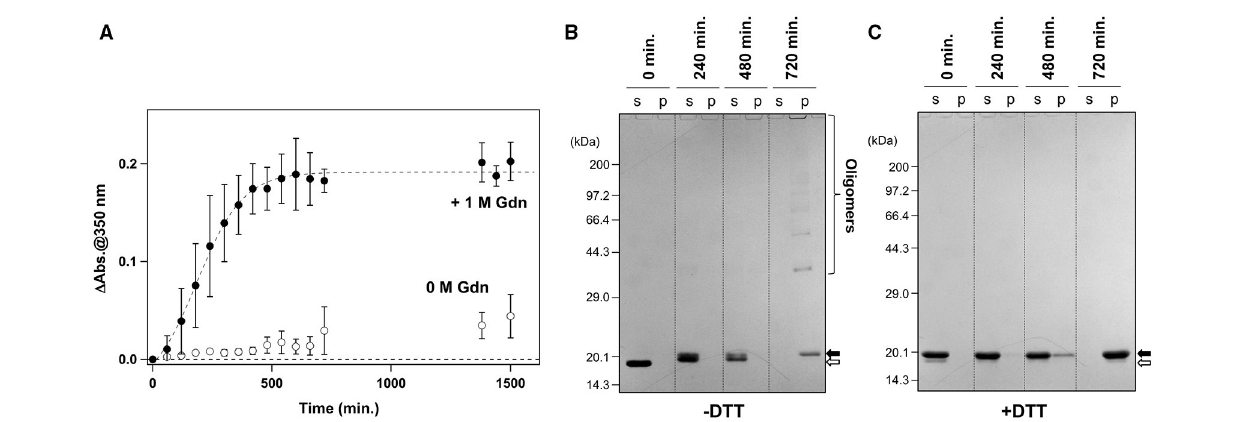
FIGURE 1 | Formation of insoluble apo-SOD1(G37R) S-S oligomers by structural destabilization. (A) Formation kinetics of insoluble aggregates from 20 µ M apo-SOD1(G37R) S - S was monitored by the increase of solution turbidity (absorbance at 350nm) in the absence (open circles) and presence (filled circles) of 1MGdn. Experiments were repeated more than three times to estimate error bars (standard deviation). (B,C) During the aggregation of apo-SOD1(G37R) S - S shown in (A) , aliquots were taken from the sample solution at the indicated time, fractionated into soluble supernatant (s), and insoluble pellet (p) by ultracentrifugation and then analyzed by (B) non-reducing SDS-PAGE and (C) reducing SDS-PAGE after treatment of the samples with DTT. The bands corresponding to SOD1 proteins with and without the canonical disulfide bond are indicated by open and filled arrows,